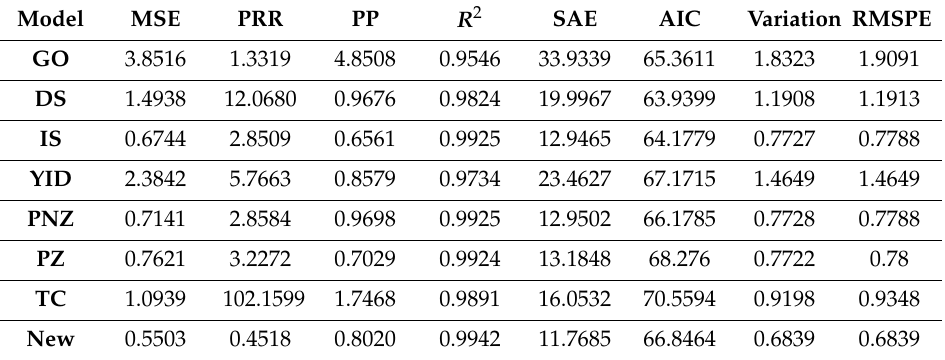
Table 4. Comparison of all criteria for dataset 1.